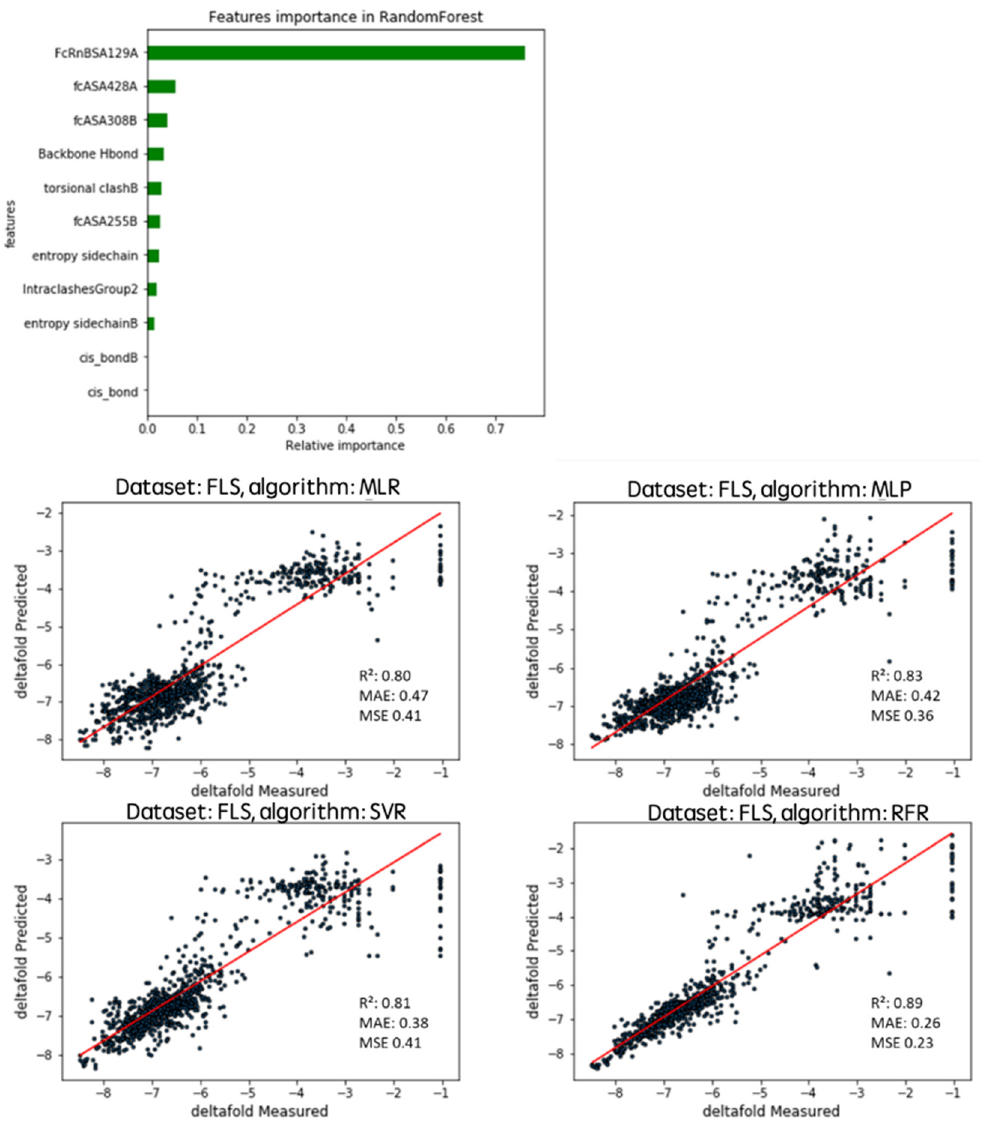
Figure A1. Model with Foldx.